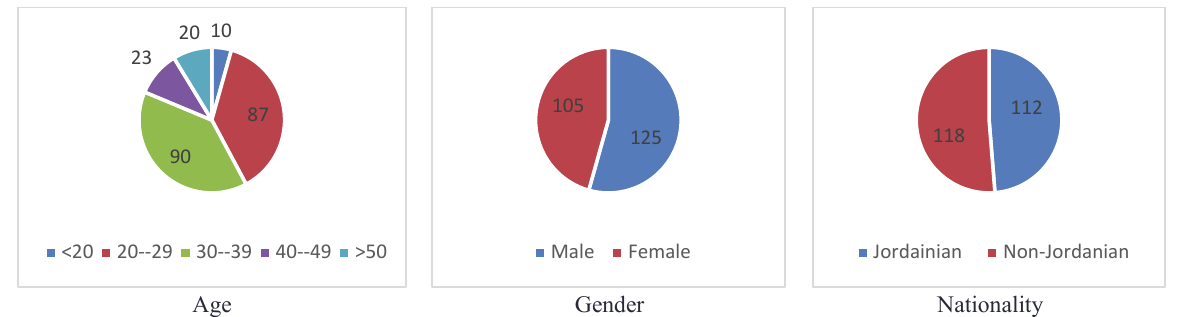
Fig. 2. Personal characteristics of the participants